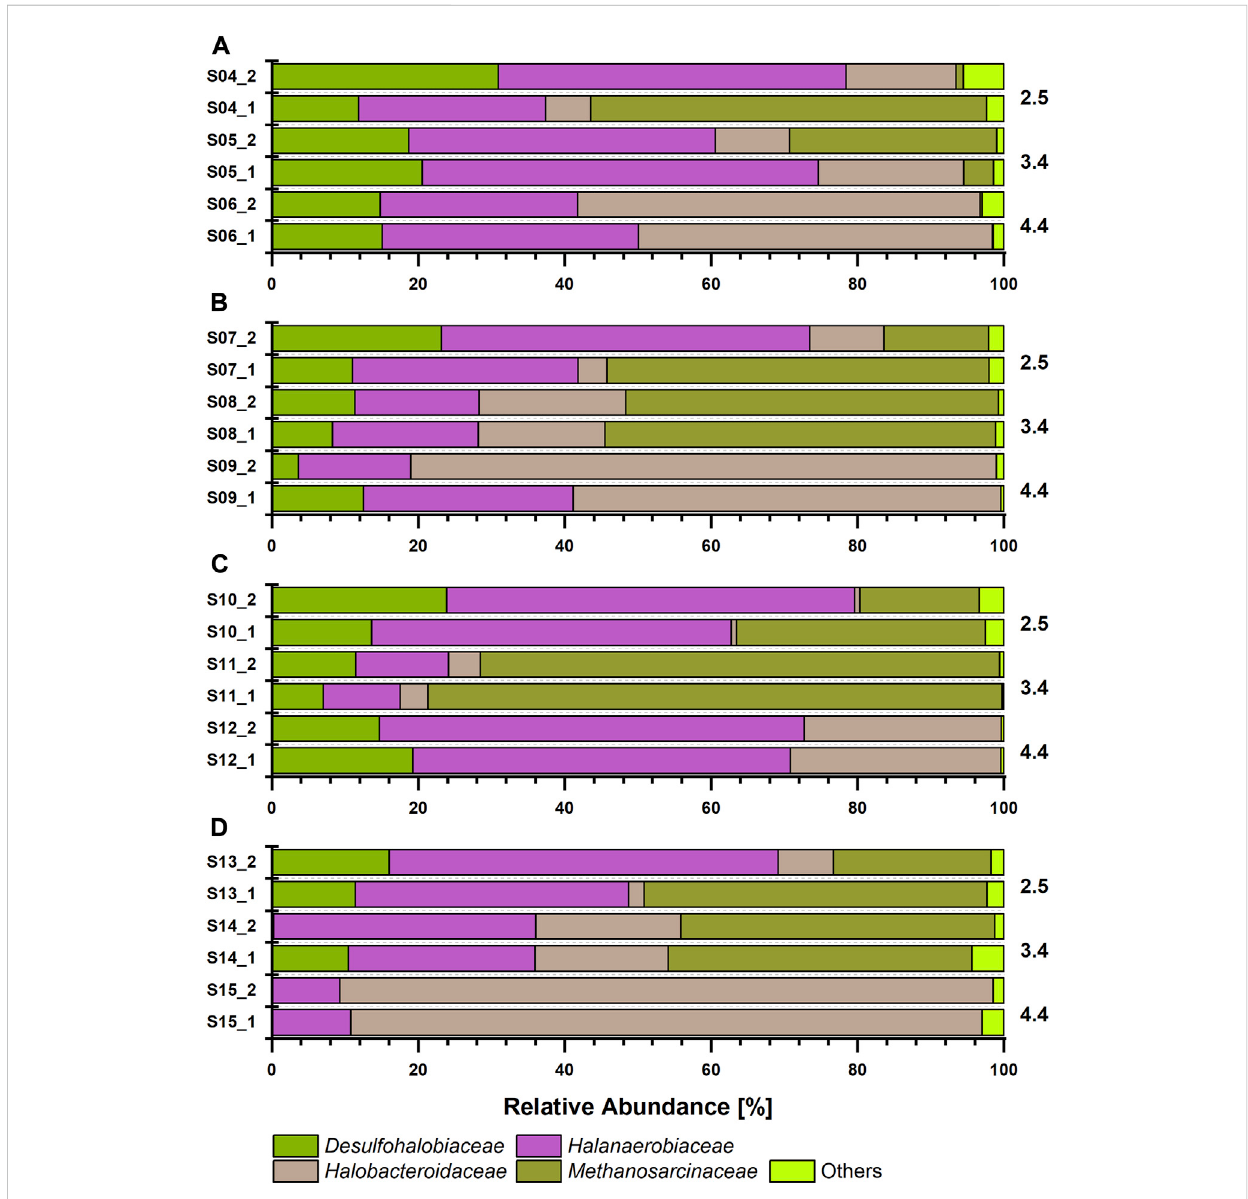
FIGURE 2 Prokaryotic relative sequence read abundances according to 16S rRNA gene-based amplicon sequencing after incubation for 125 days at 30 ° C grownatthreesalinitylevels(2.5,3.4and4.4